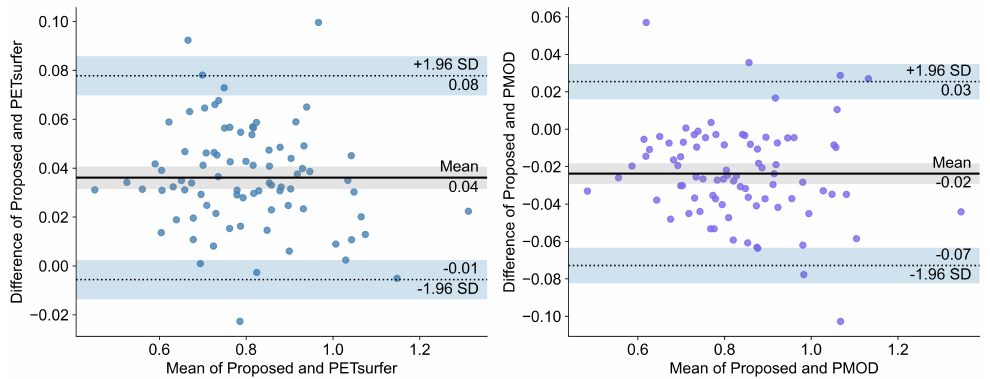
Figure 2. Intraclass correlation for PETSurfer, PMOD, and the proposed method. Dashed line shows that the ICC value is 0.75.